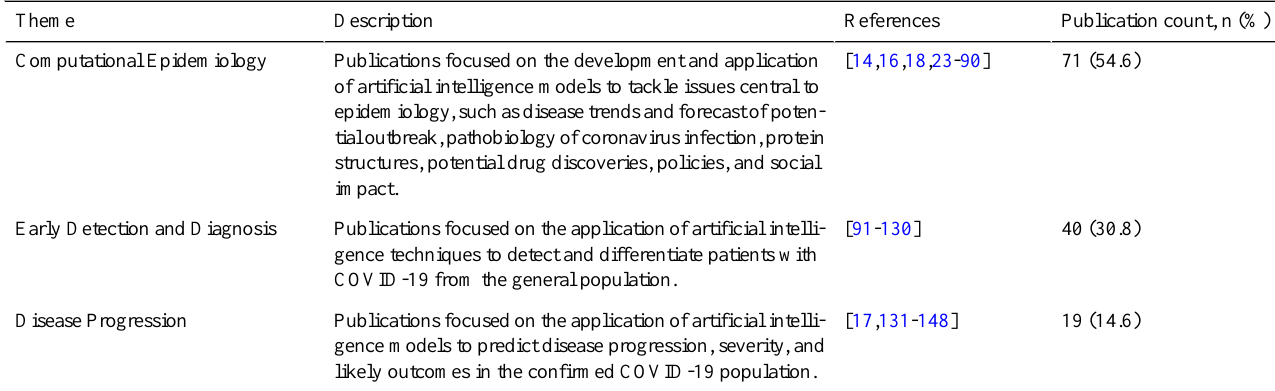
Table 1. An overview of the 130 publications in the literature, classified into 3 themes and their descriptions. The themes are listed according to the frequency of publication (percentage and absolute count).